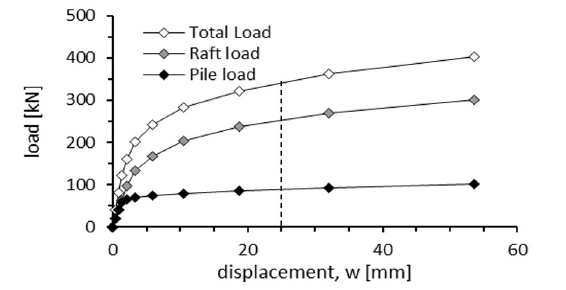
Figure 14. Load-settlement curves for case 7 - L=4m; t=0.3m